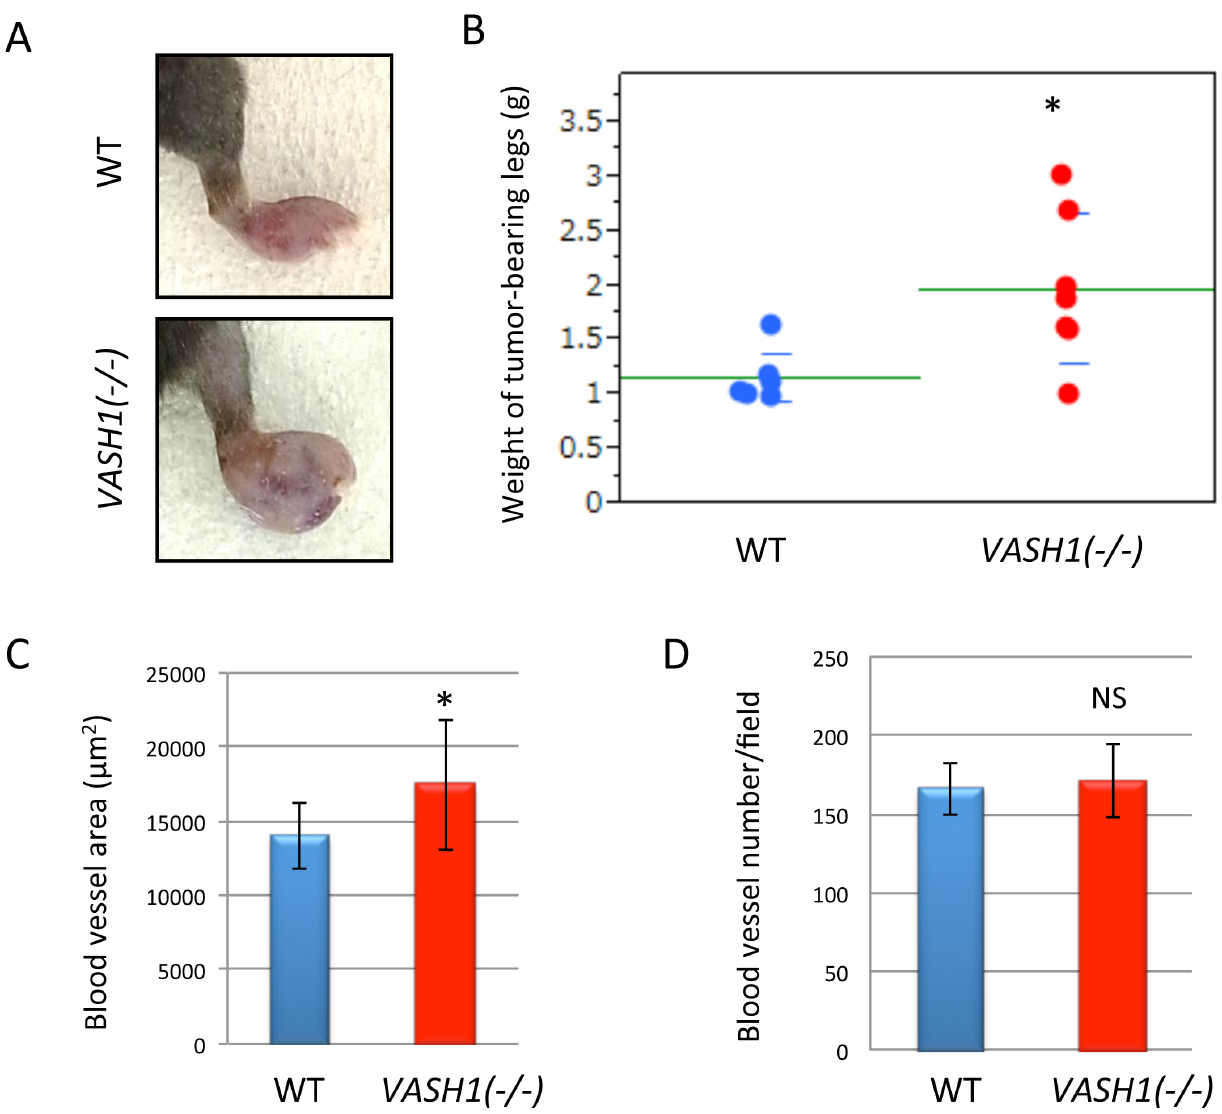
Figure 1. Primary tumors in the footpad. LLC cells were inoculated in the right hind footpad of WT and VASH1 ( 2 / 2 ) mice. A: Gross appearance on day 16 to 18 after the inoculation. B: Weight of tumor-bearing legs. *p , 0.05. C: Tumor sections were immunostained with CD31, and the vascular area was determined as described in Materials and Methods. Means and SDs are shown (N=7). *p , 0.05. D: Tumor sections were immunostained with CD31, and vascular number was determined as described in Materials and Methods. Means and SDs are given (N=7). NS: not